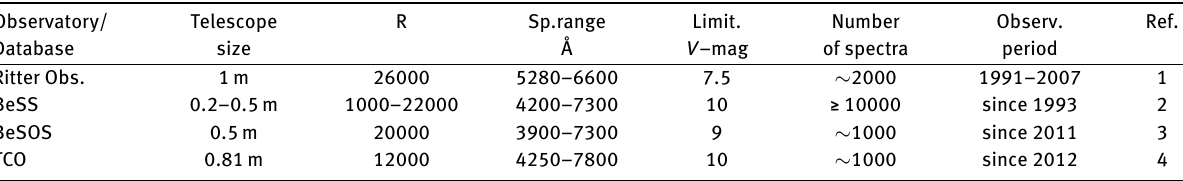
Column information: 1 – shows the name of the observatory or database, 2 – lists the telescope(s) primary mirror diameter, 3 – spectral resolving power(s), 4 – typical spectral range of the data, 5 – limiting V –magnitude, 6 – approximate number of spectra of Be stars contained in the database (keeps growing with time), 7 – lists timeframes when the data were taken, 8 – references to the database websites or